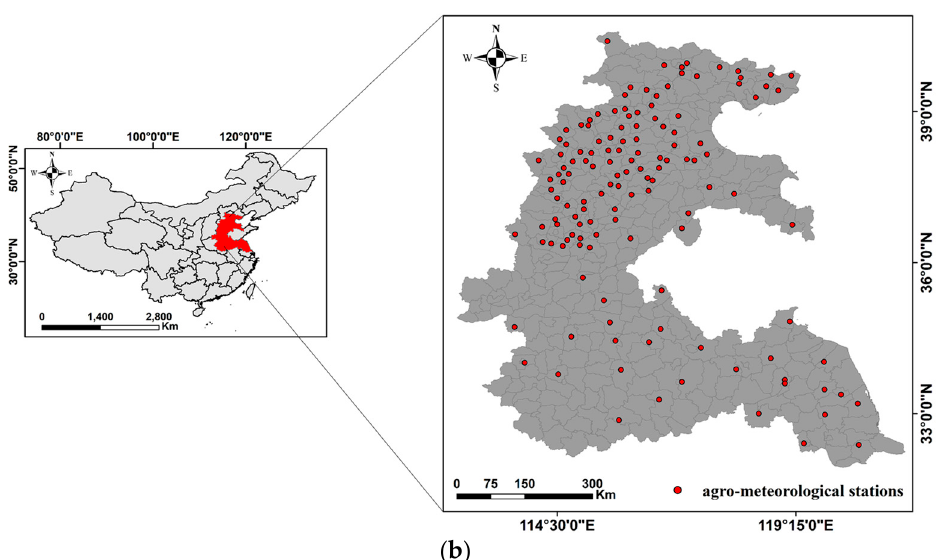
Figure 1. Maps of study areas. ( a ) Major crop distribution across Kansas (Image based on data from the 2017 National Agricultural Statistics Service Cropland Data Layer). ( b ) North China Plain (NCP).